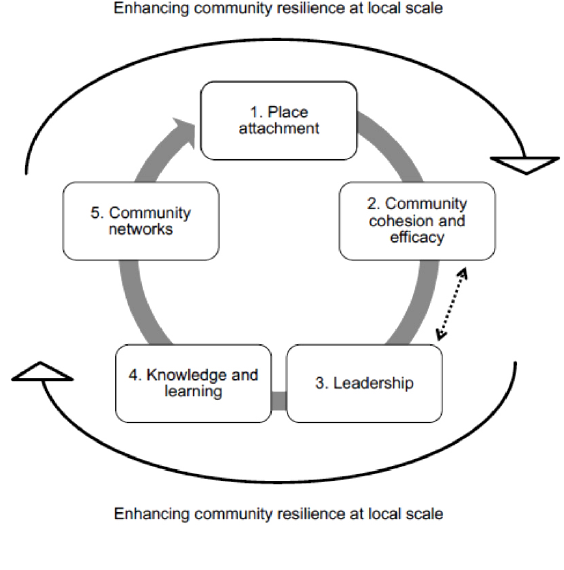
Fig. 3. Prioritization of community resilience capacities from resident perceptions in Wadebridge on a scale of 1 to 5 (number 1 represents the most important capacity for community resilience, and number 5 represents the least